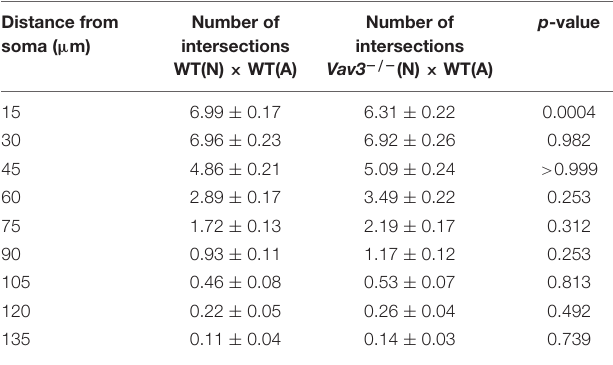
TABLE 2 | Intersection numbers of Vav3 − / − neurons compared to the control condition after a cultivation time of 12 days.